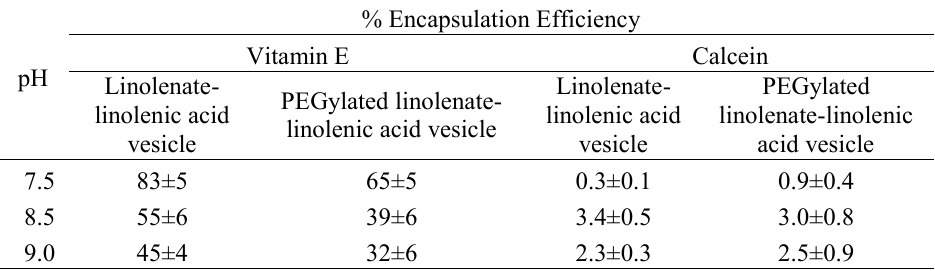
Table 2. Percentage encapsulation efficiency of linolenate-linolenic acid vesicle